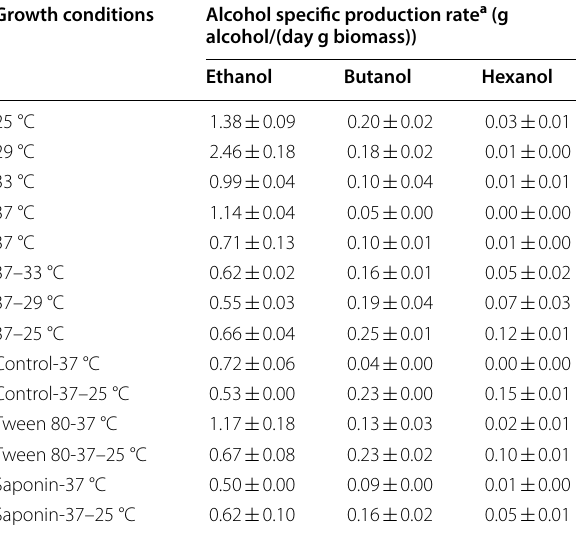
a Mean values and standard errors of three replicates are shown